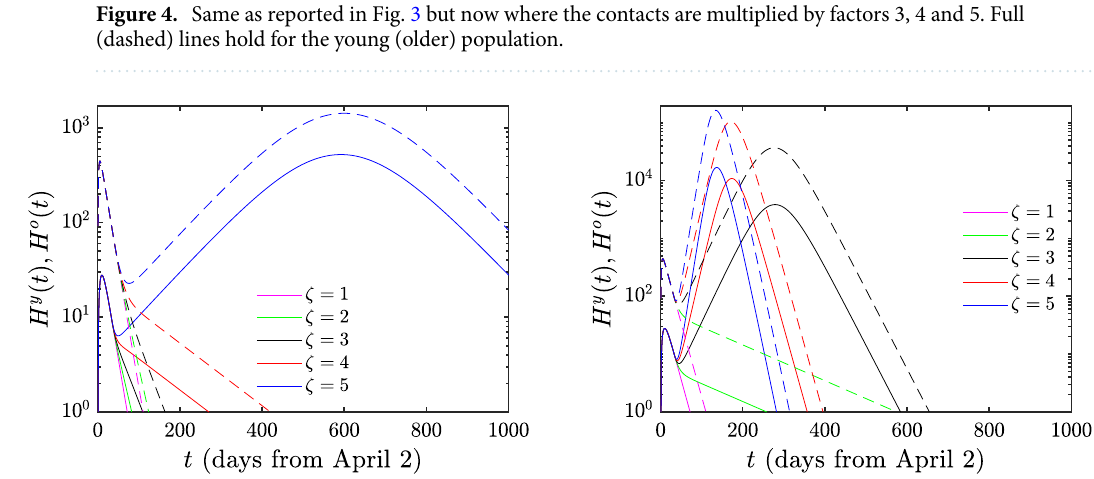
Figure 5. Hospitalizations when only the young population (left) or both the young and older (right) population are released. Full (dashed) lines hold for the young (older)